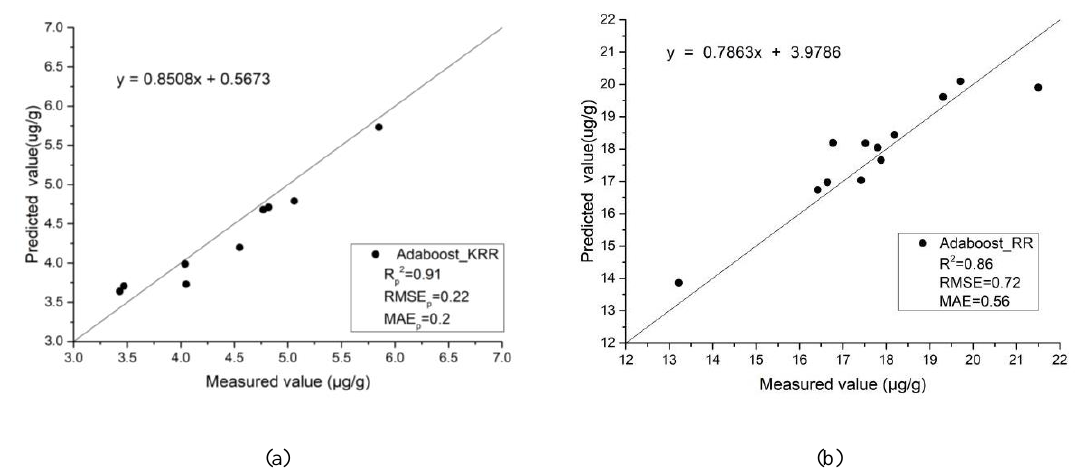
Figure 7. Comparison of the measured and predicted values of the di ff erent models:( a ) northwest China and ( b ) Honghu.